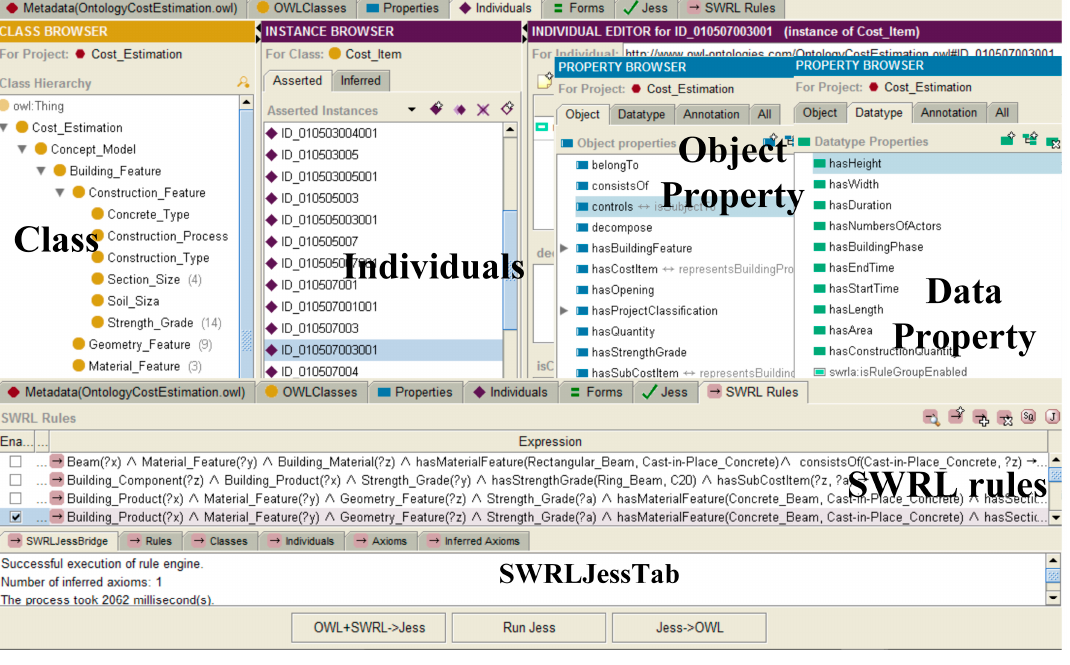
Figure 9. Graphical user interface of Protégé.